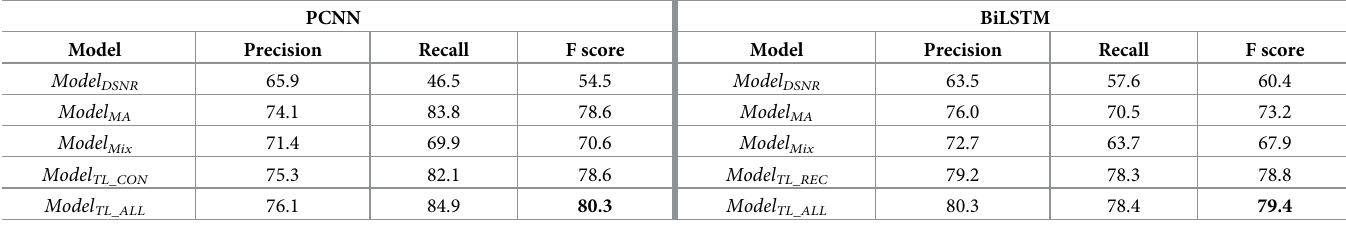
Table 3. Results of deep learning models on